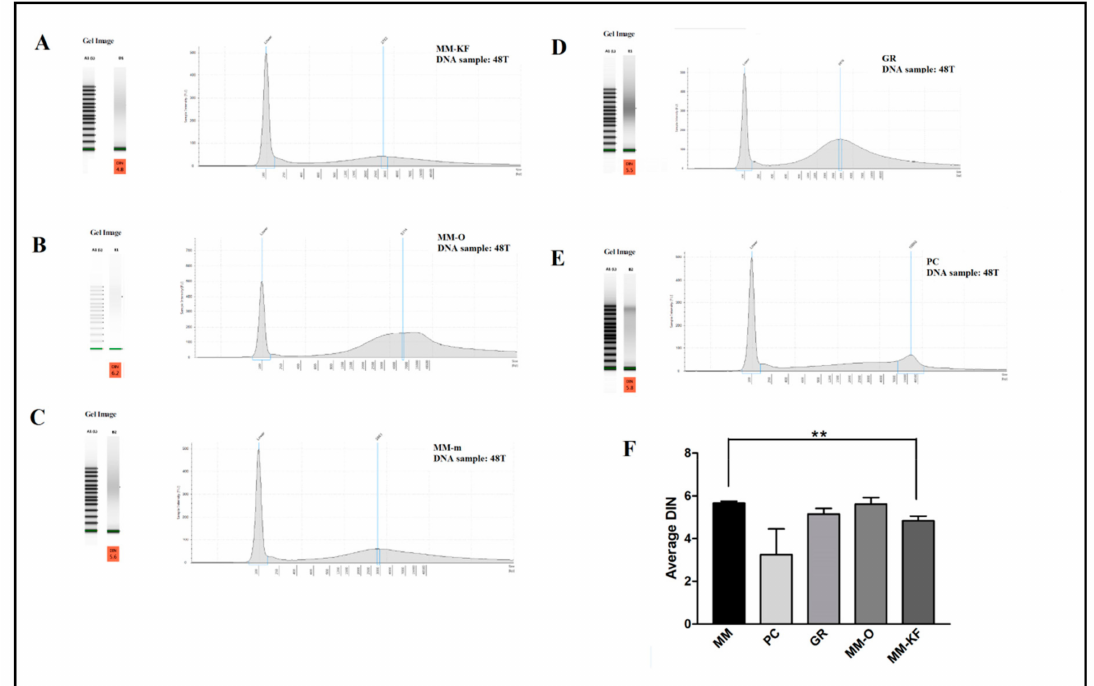
Figure 1. Five representative DNA samples from the same tissue block visualized using the TapeStation instrument. Profile of DNA extracted from the 48T sample using: ( A ) MM-KF, ( B ) MM-O, and ( C ) MM manual. Profile of DNA extracted from the 48T sample using: ( D ) GR kit, and ( E ) PC procedures. ( F ) Comparative results of DIN values (mean ± SE) for all six DNA samples from FFPE samples (24N, 24T, 48N, 48T, 72N, 72T) obtained by di ff erent extraction methods. ** p < 0.001, t -test. SE, standard